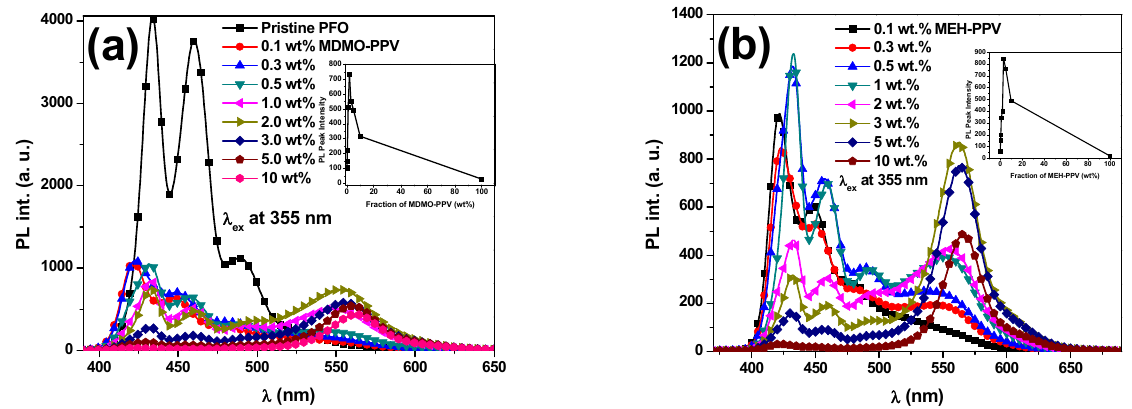
Figure 3. Emission intensity of the hybrids of PFO with different weight ratios of ( a ) MDMO-PPV–DMP and ( b ) MEH- PPV. All emission intensities were reduced ~20 times by using specific filter to avoid the saturation during the collection spectra. Insets in ( a , b ) are PL peak intensity of the hybrids measured at 550 and 565 nm as a function of the fraction of MDMO-PPV–DMP and MEH-PPV in weight percent ratio, respectively.